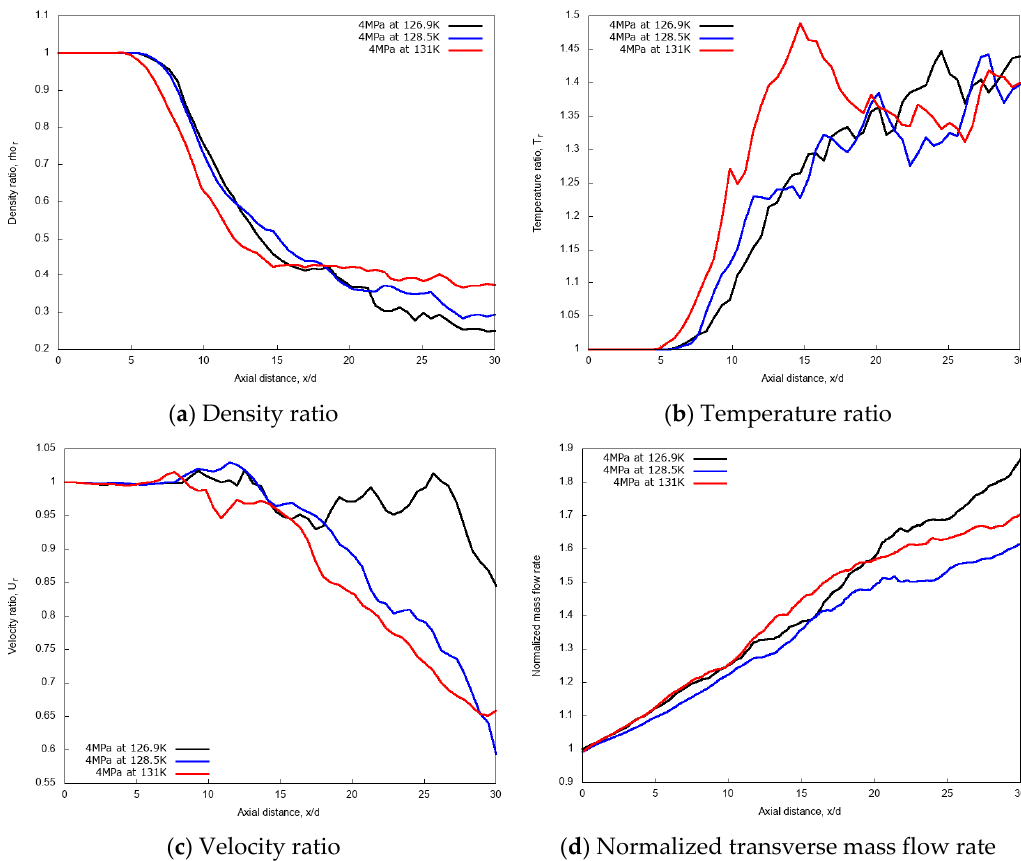
Figure 6. Centerline axial profiles of non-dimensional density, temperature, velocity and normalized transverse mass flow rate for different injection temperatures: 126.9 K, 128.5 K, and 131 K. Simulations of cryogenic L-N 2 injected at 4.9 m/s into G-N 2 at 4 MPa and 298 K.